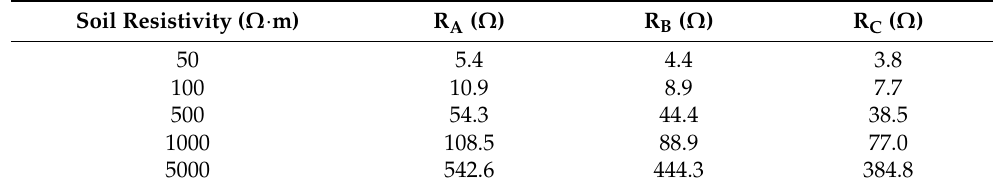
Table 4. Power frequency grounding resistances under different soil resistivities in the equal cross- sectional area